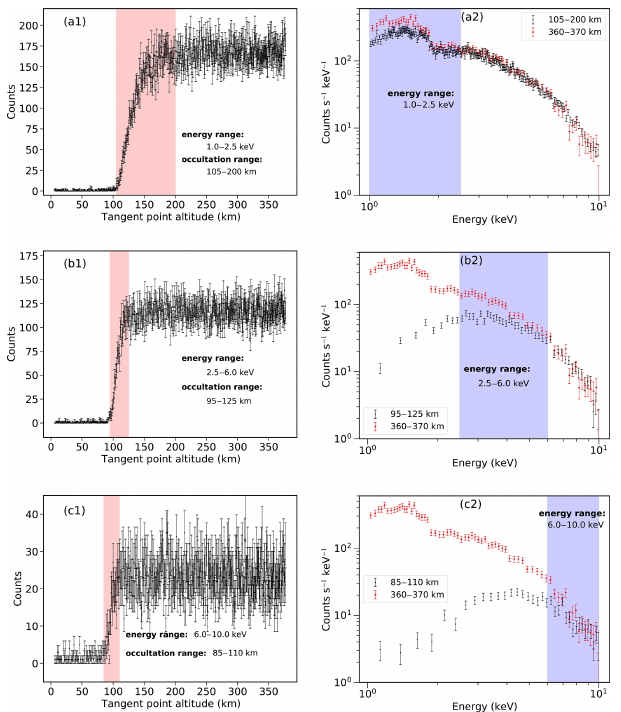
Figure 9. Light curve and energy spectrum during occultation. Panel (a1) represents the light curve in the energy range of 1.0– 2.5keV, and it is found that this energy band is indeed sensitive to the altitude range of 105–200km. Panel (a2) shows the comparison between the energy spectrum in the altitude range of 105–200km and the unattenuated energy spectrum, and it is found that there is a significant attenuation of the energy spectrum in the altitude range in the range of 1.0–2.5keV. Panel (b1) represents the light curve in the energy range of 2.5–6.0keV, and it is found that this energy band is indeed sensitive to the altitude range of 95–125km. Panel (b2) shows the comparison between the energy spectrum in this al- titude range and the unattenuated energy spectrum, and it is found that the energy spectrum in this altitude range has significant at- tenuation in the energy range of 2.5–6.0keV. Panel (c1) represents the light curve in the energy range of 6.0–10.0keV, which is indeed sensitive to the altitude range of 85–110km. Panel (c2) shows the comparison between the energy spectrum in this altitude range and the unattenuated energy spectrum, and it is found that the energy spectrum in this altitude range has significant attenuation in the en- ergy range of 6.0–10.0keV. The red shading marks the occultation range, and the blue shading marks the energy